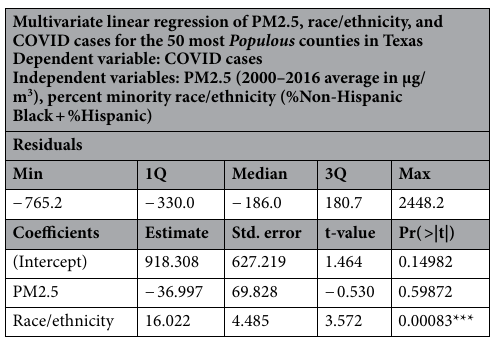
Table 2. Regression of PM 2.5 , race, and COVID-19 cases for the 50 most populous counties in Texas. Signif. codes: 0 ‘***’ 0.001 ‘**’ 0.01 ‘*’ 0.05 ‘.’ 0.1 ‘ ’ 1. Multiple R-squared: 0.2135, Adjusted R-squared: 0.1801. Residual standard error: 590.3 on 47 degrees of freedom. F-statistic: 6.38 on 2 and 47 degrees of freedom, p-value: 0.003536.